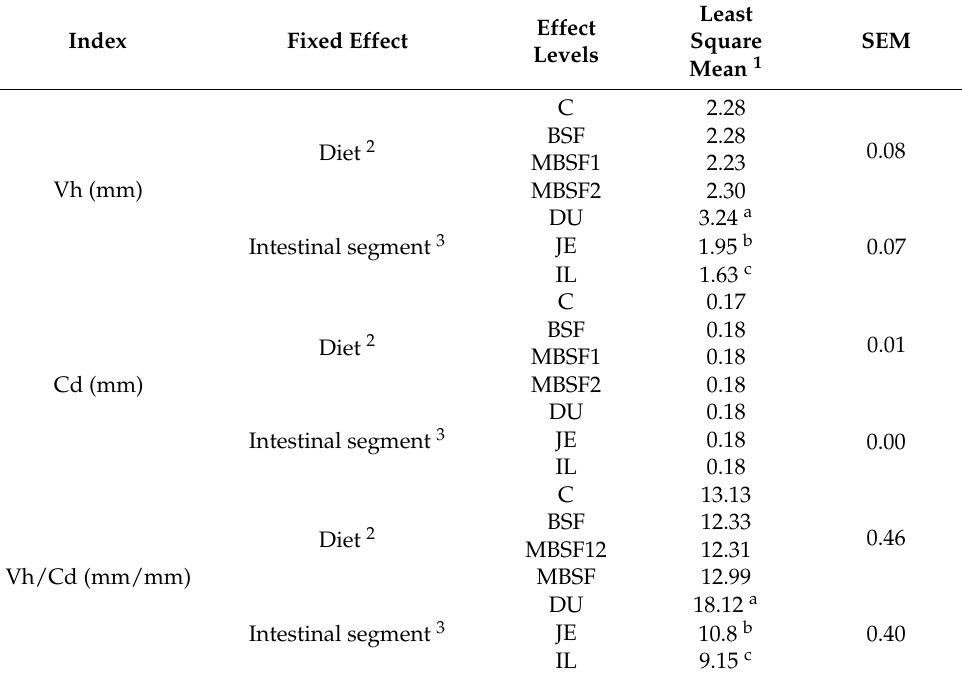
Table 8. Least square means of intestinal morphometric indices in broilers in relation to diet and intestinal segment (n =